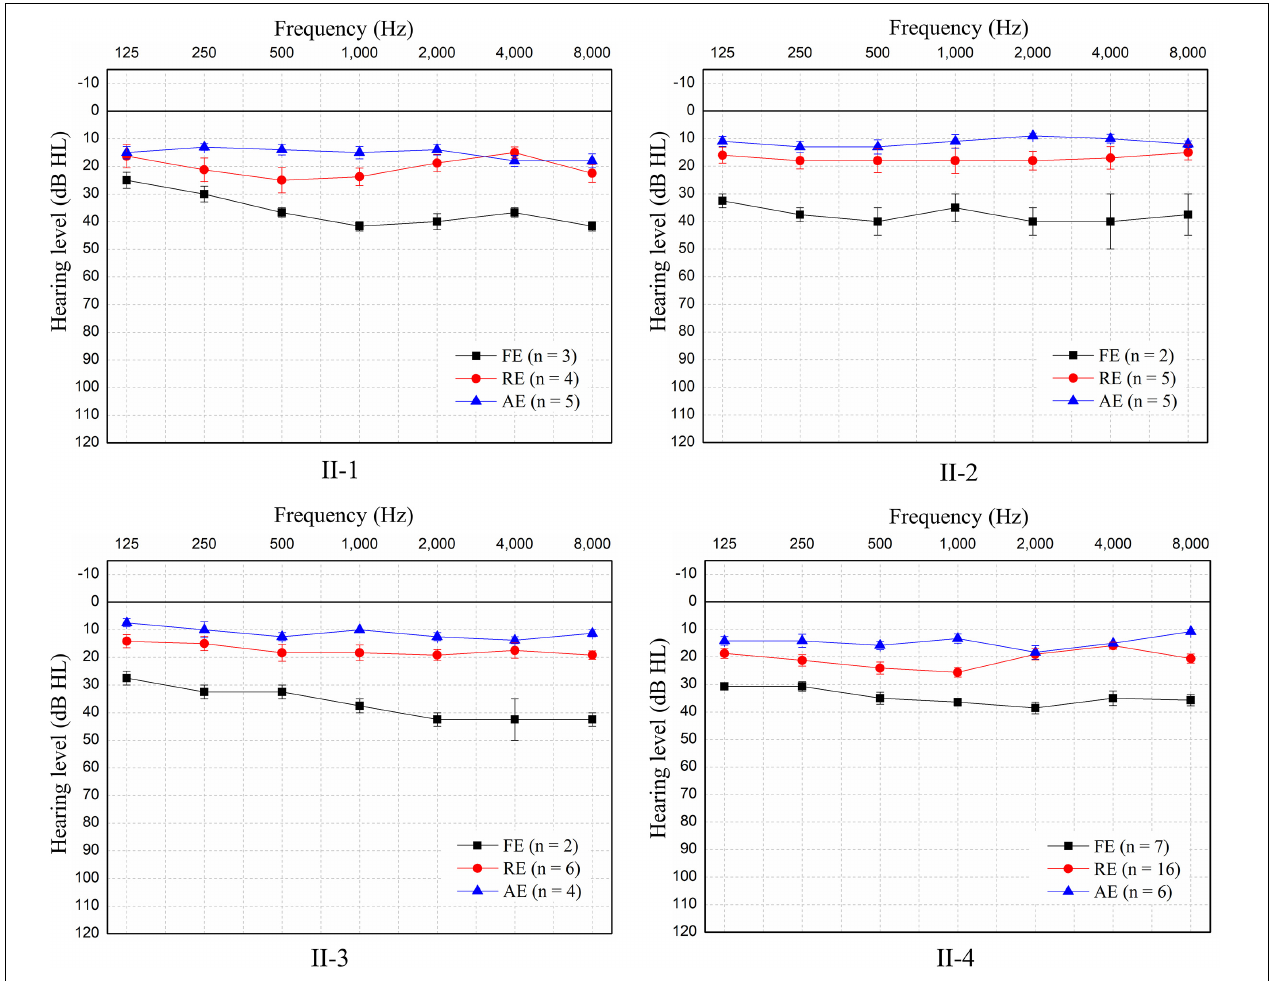
FIGURE 3 | Pure-tone audiometry of the four patients during the three episodes. Since no air-bone gap was found, only pure-tone air-conducted thresholds for the better ear for each patient are shown. Patients experienced mild sensorineural hearing loss during each febrile episode (FE), but hearing returned to normal in the recovery episode (RE) and remained normal in the afebrile episode (AE). The hearing threshold at each frequency is shown as the mean ± SEM of the air-conduction threshold. N: number of test